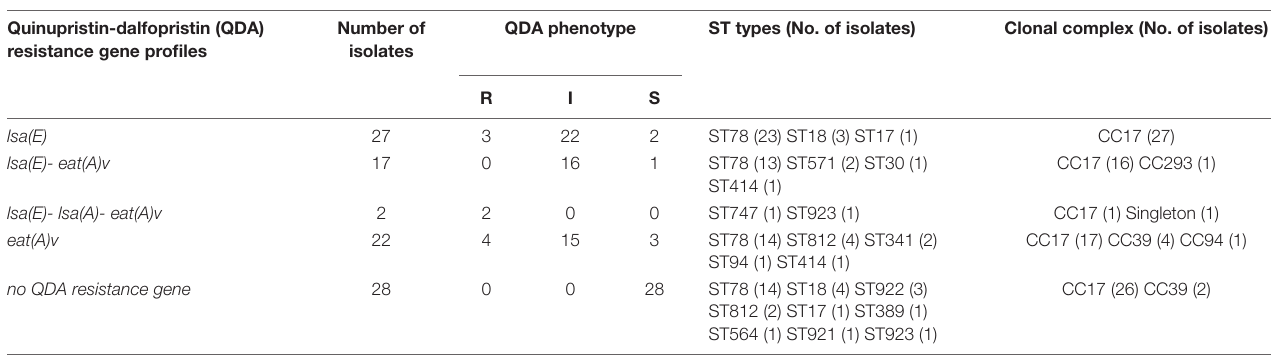
TABLE 2 | Quinupristin-dalfopristin (QDA) resistance gene profiles and ST types in E. faecium strains isolated from patients. Quinupristin-dalfopristin (QDA) resistance gene